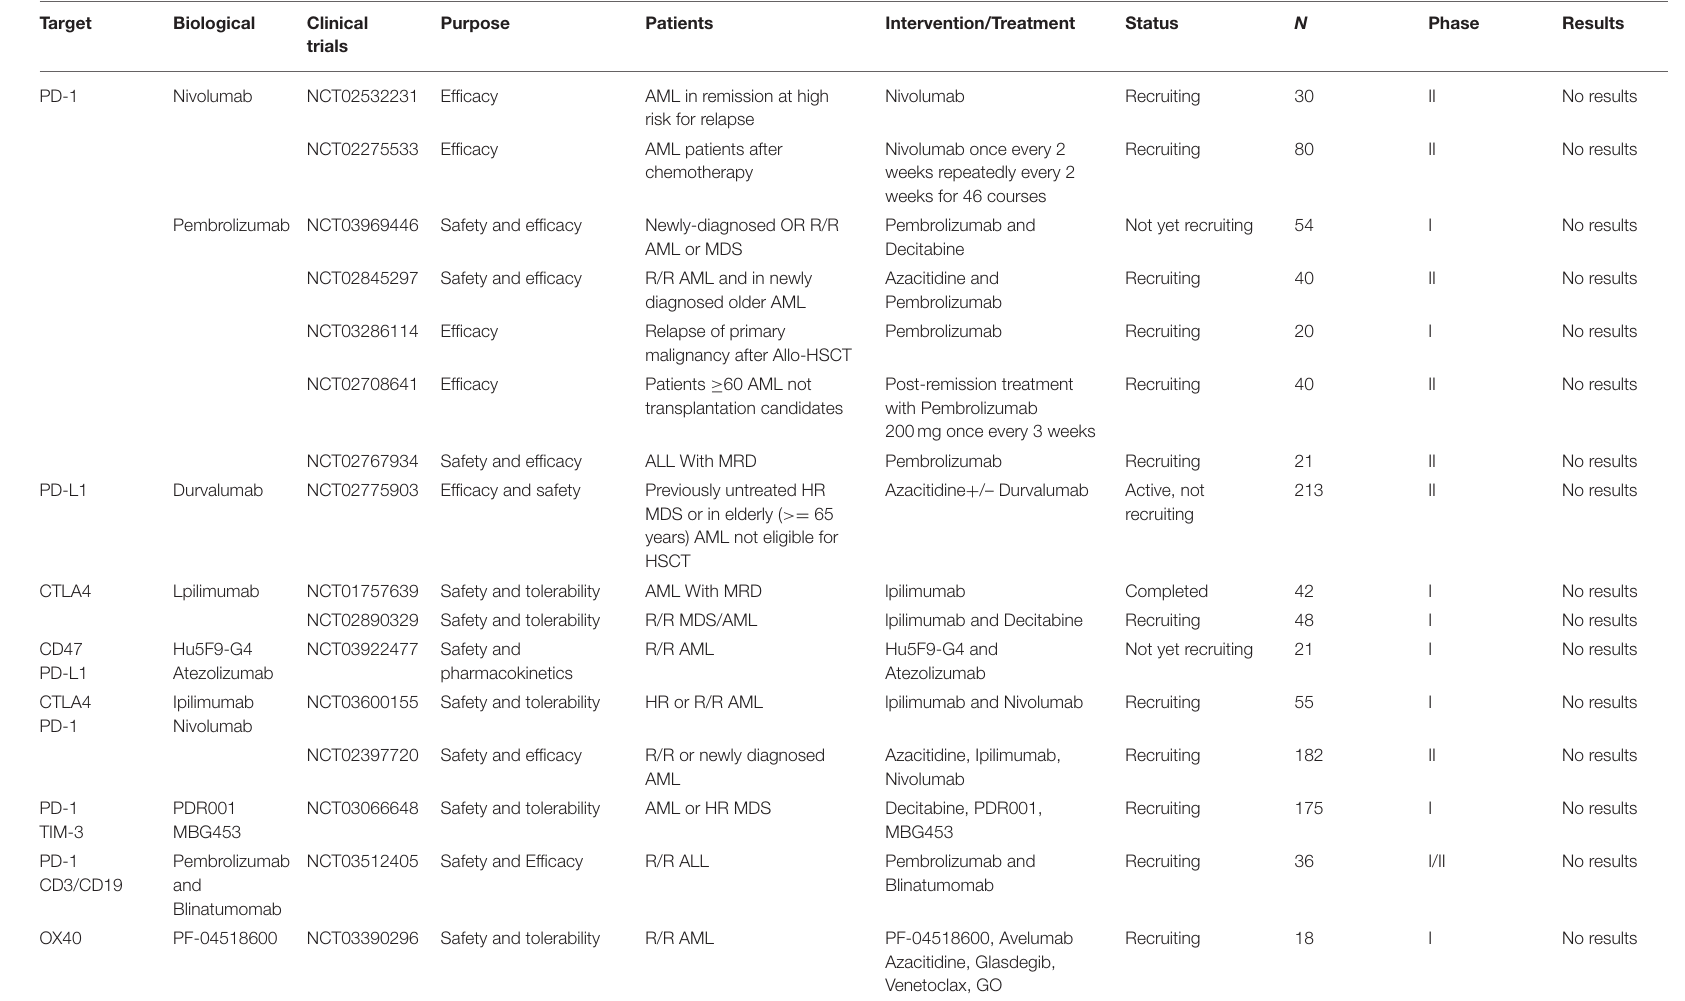
TABLE 5 | Selected completed or ongoing trials of Immune Checkpoint Inhibitor therapy for AML and